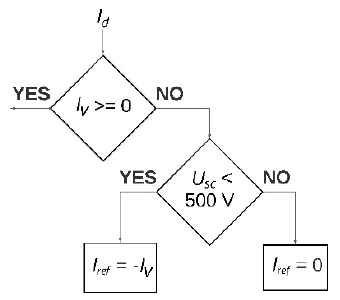
Figure 8. Flow diagram for supercapacitor regenerative braking charging zone.